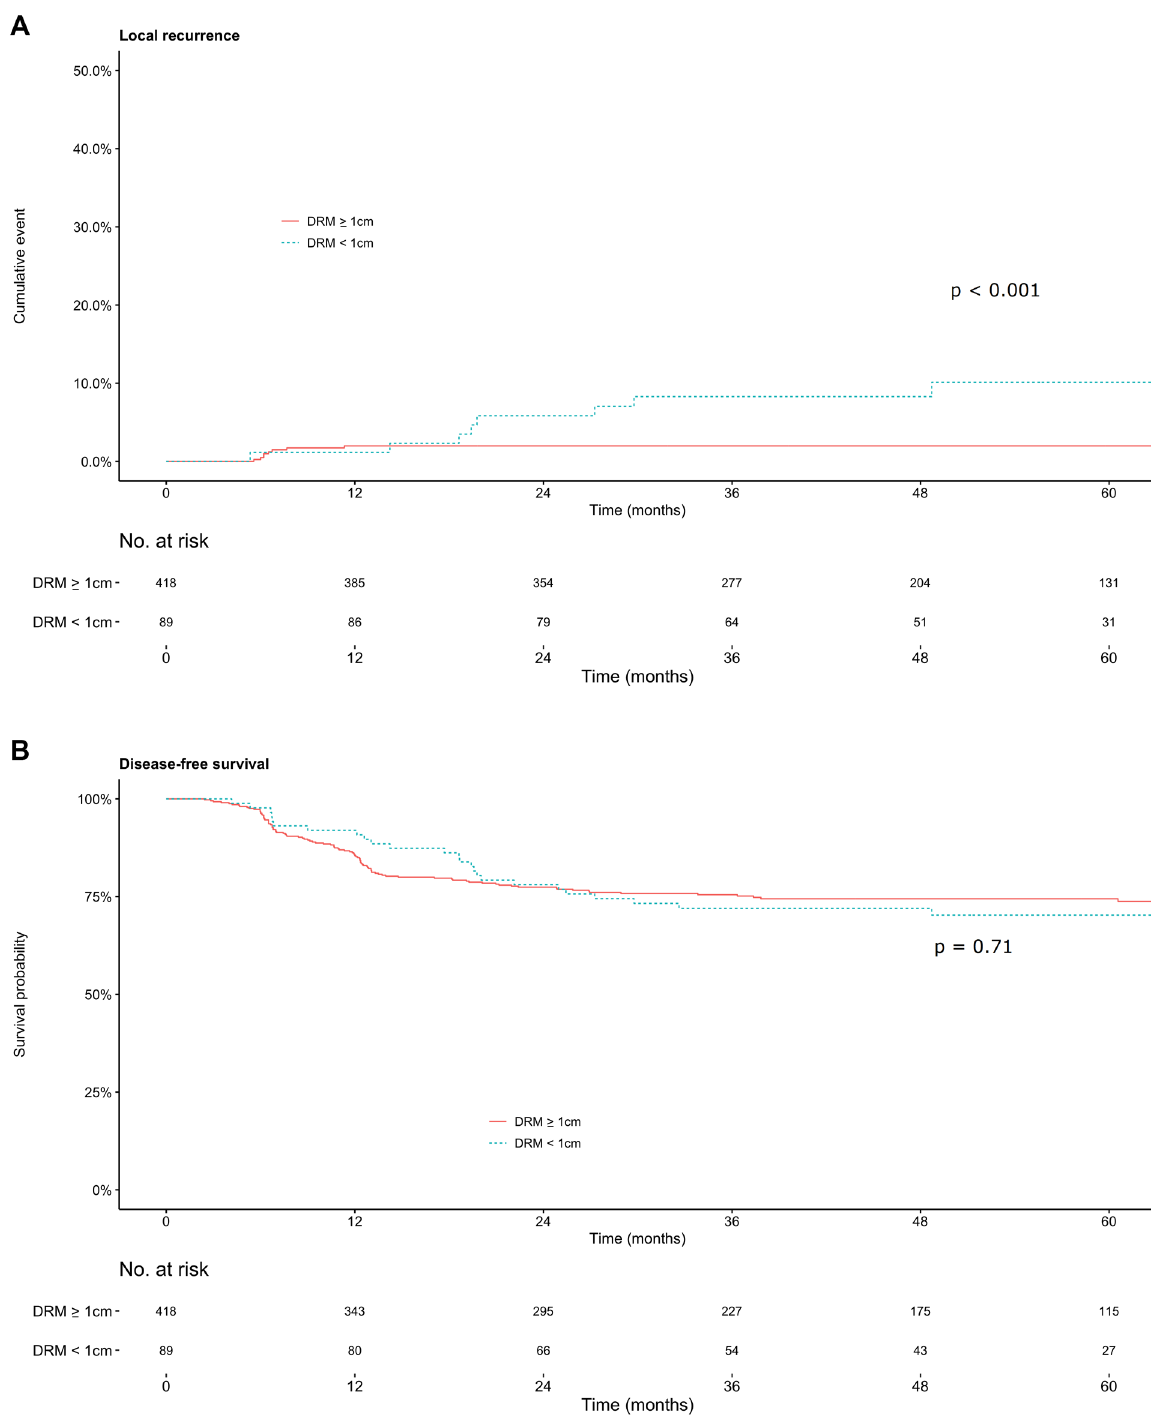
Figure 2. Cumulative incidence of local recurrence ( a ) and disease-free survival ( b ) in patients with locally advanced rectal cancer who underwent preoperative chemoradiotherapy followed by rectal